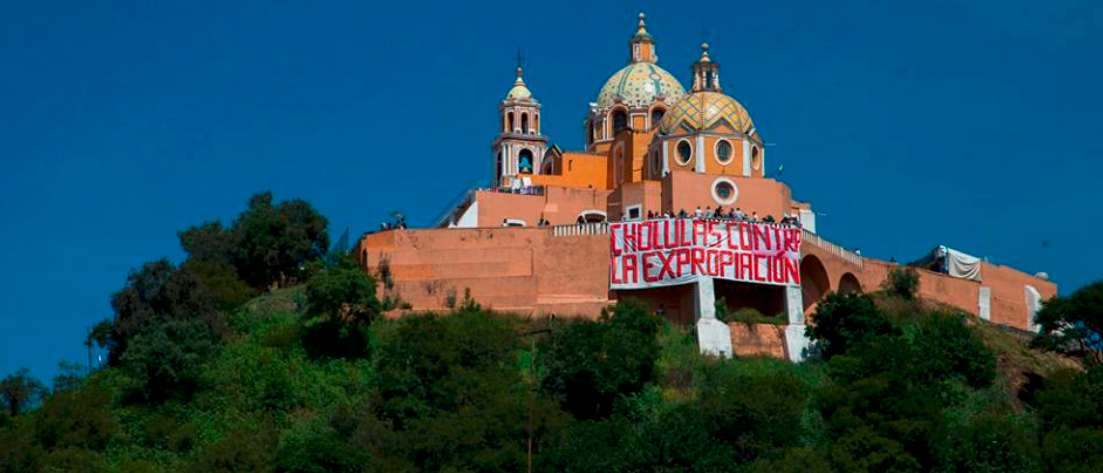
Figure 5. The Sanctuary of la Virgen de los Remedios over the Great Pyramid used as a billboard for social protest against expropriation. Source: Círculo de Defensa Cholula (2014).